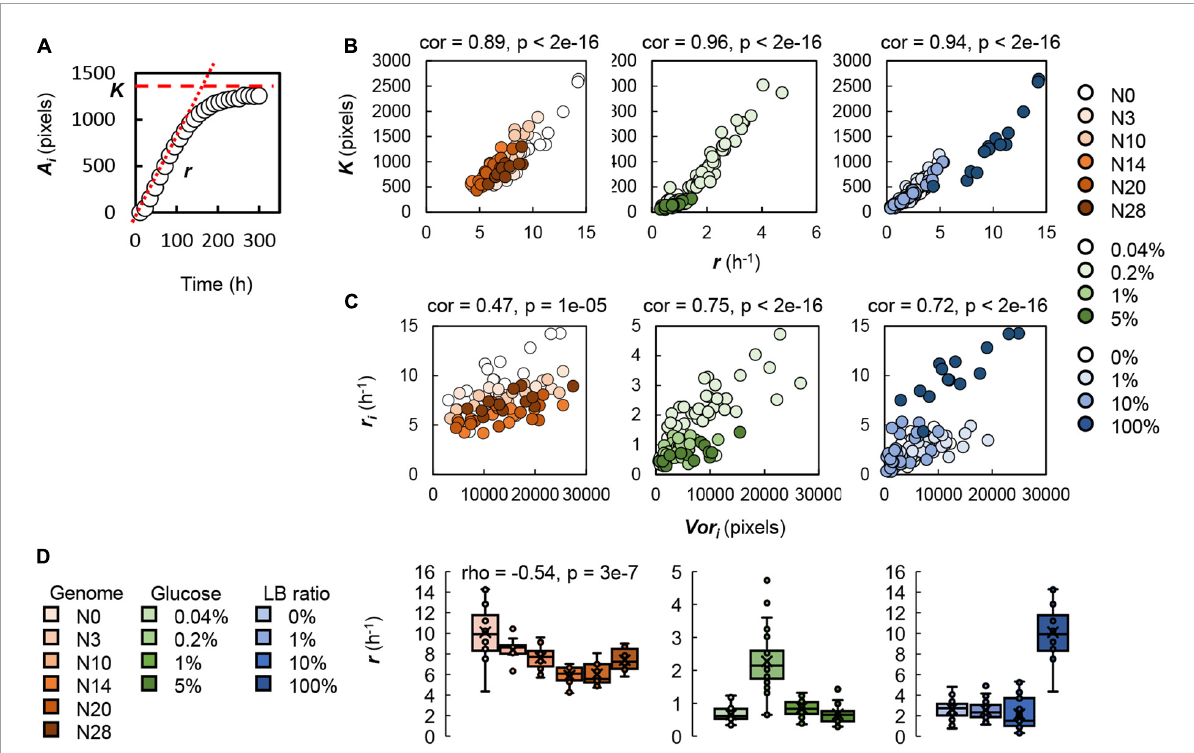
FIGURE5 Single colony analysis. (A) Growth curve of a single colony. Circles indicate the temporal changes in the colony size. The relative growth rate ( r ) and the steady size of the colony ( K ) are indicated by red dashed lines. (B) Correlation between the relative growth rate and the steady size of the colonies. (C) Correlation between the Voronoi area and the relative growth rate. Circles represent the colonies. Gradations in orange, green and blue indicate the genome size from the wild type to the reduced ones ( N = 80), the concentration gradient of glucose in the minimal medium M63 ( N = 131) and the ratio gradient of LB in the mixed medium M63LB ( N = 141). Pearson’s correlation coefficients and the statistical significance are indicated. (D) Relationships of genome reduction and nutritional richness with the growth rate. Boxplots of the relative growth rates acquired from each condition are shown. The tiny circles and the crosses represent the individual r i and the average r i , respectively. Color variation in orange, green and blue and the numbers of single colonies used for the analysis are described above. Spearman’s correlation coefficients and the p -value, which was of statistical significance, are indicated.